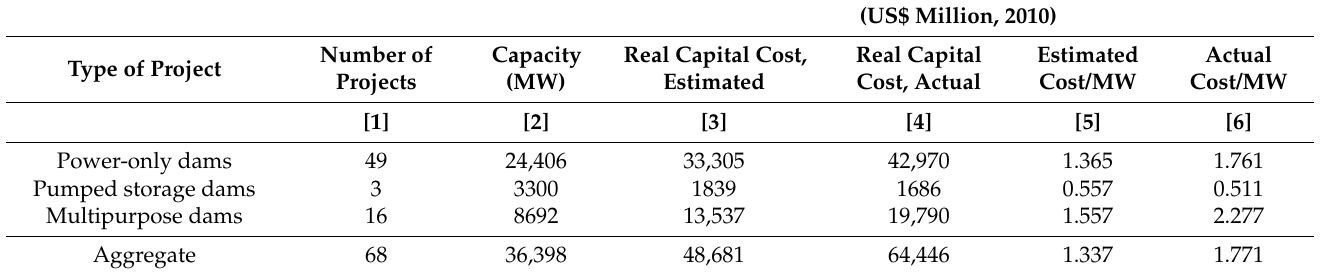
Table 1. Summary of projects by